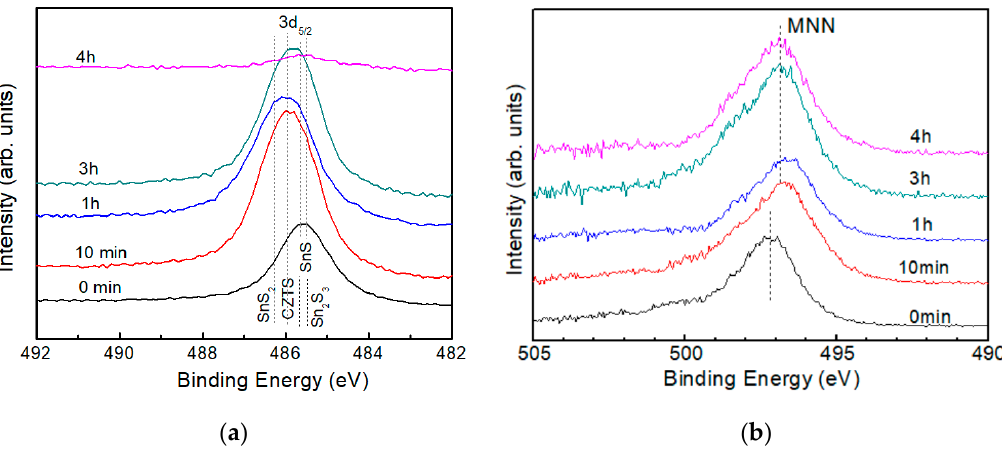
Figure 8. ( a ) XPS spectra of Sn 3d 3/2 and ( b ) Auger electron spectra of Sn MNN of a CZTS film. The dotted lines in ( a ) indicate peak positions of Sn in SnS compounds and CZTS and in ( b ) indicate peak positions of the Auger electron spectra.